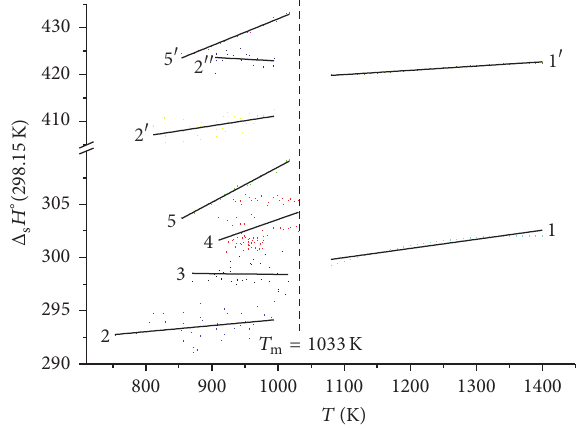
Figure 6: Temperature dependencies of the third law 𝐻 ∘ (298.15 K) values: ( 1 ) monomer from [9], ( 2 ) our data, Δ s ( 3 ) [2], ( 4 ) [7], and ( 5 ) [6]; (1 󸀠 ) dimer from [9], (2 󸀠 ) our data, and (5 󸀠 ) [6]; ( 2 󸀠󸀠 ) trimer our